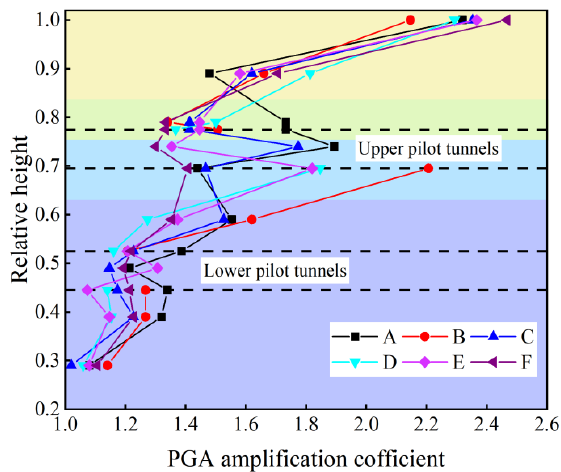
Figure 11. Variation in horizontal amplification coefficient of monitoring points along the model height.